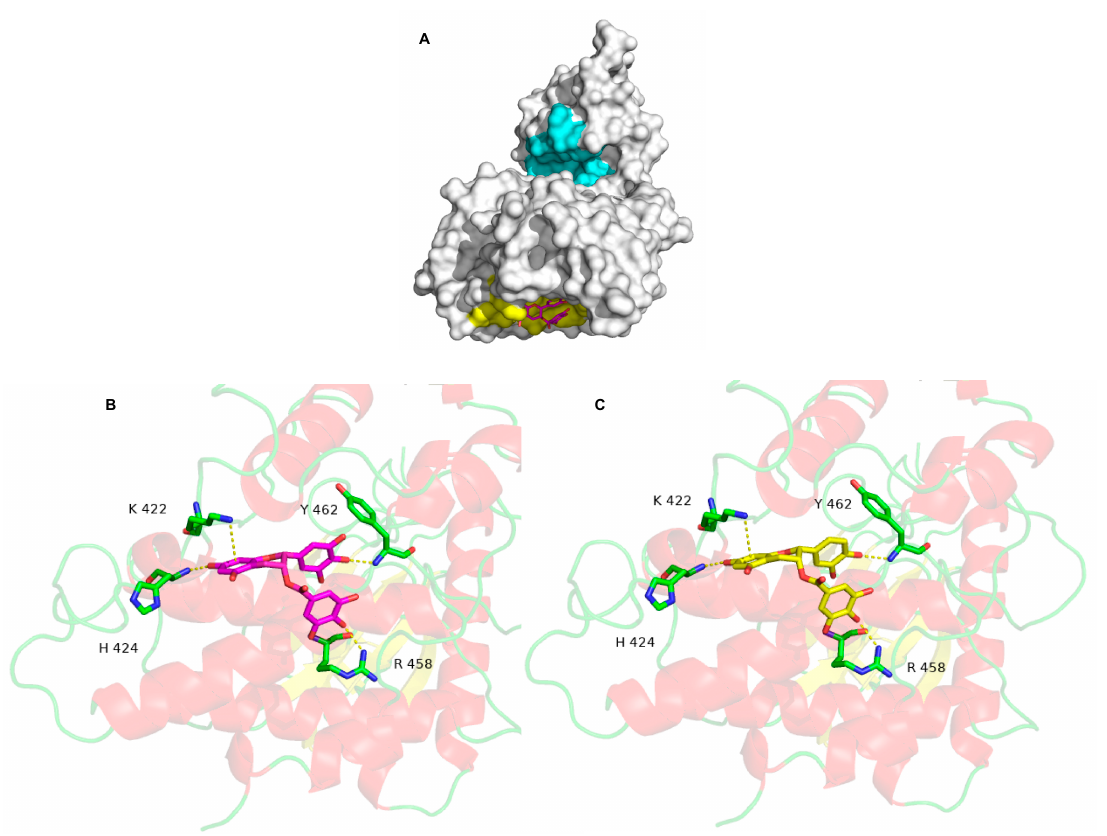
Figure 2. The molecular surface of DYRK1A is shown in white, in cyan, the catalytic site and in yellow, the most probable binding of EGCG located around the L 457 ( A ). EGCG is represented by stick models and its carbon atoms are colored in magenta. Detailed interactions between DYRK1A and EGCG ( B ), and ECG ( C ).